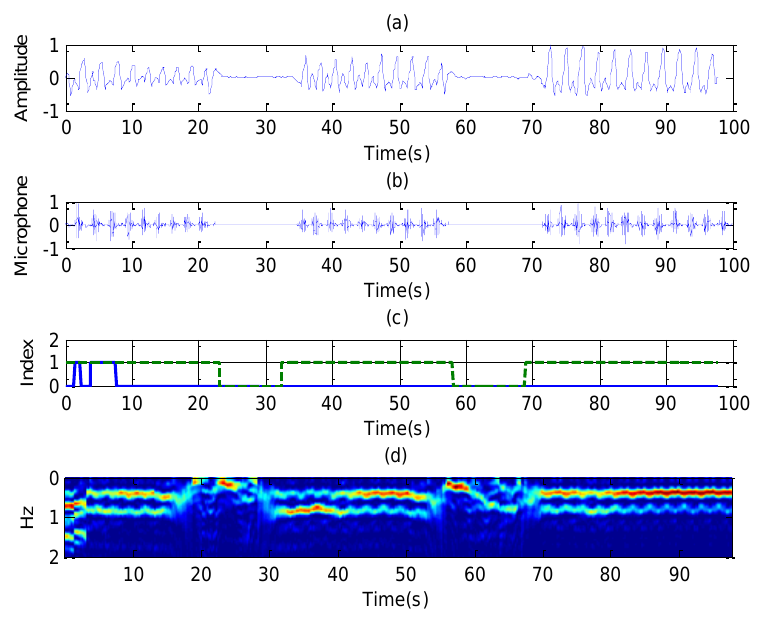
Figure 10. Results for a subject with simulated periods of apnoea (case Figure 6c,d), channel 1 (left), and channel 2 (right). For the channel 1: ( a ) Breathing signal, ( b ) recorded signal from a microphone, ( c ) movement index (solid line) and breathing index (dashed line), ( d ) periodogram obtained from channel 1. For the channel 2: ( e ) Breathing signal, ( f ) recorded signal from a microphone, ( g ) movement index (solid line) and breathing index (dashed line), ( h ) periodogram obtained from channel